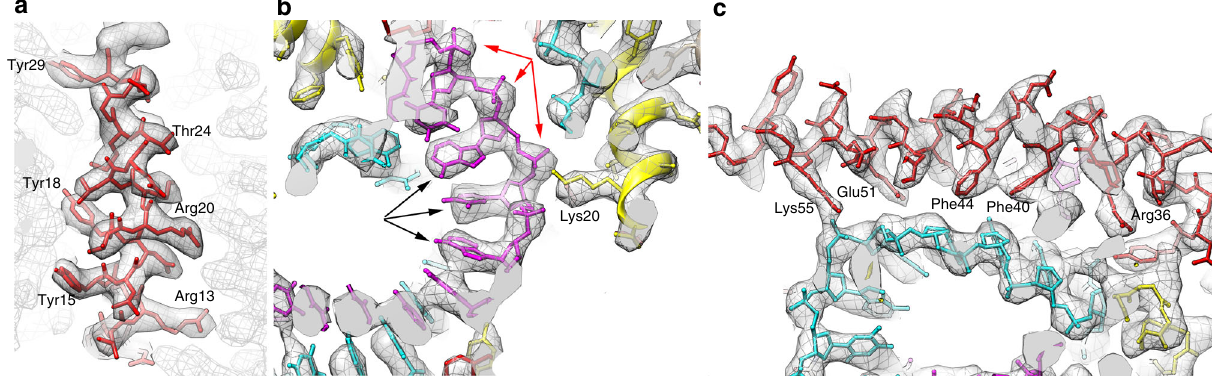
Fig. 4 The resolution of the map allows for an unambiguous modeling of both the protein and the DNA. a A helix from VP5 shows how almost all side chains can be visualized and built into the model. b A section of the DNA is shown, with one chain in magenta and the other in cyan. Even though the reconstruction is averaging over the whole genome, most of the bases are clearly resolved (black arrows) and the discrete densities from the phosphate groups are seen (red arrows). A positively-charged side chain from VP4 (Lys20) is adjacent to the negatively-charged phosphate groups. c The wrapping of the DNA (cyan) by VP5 (red). Two positively-charged sidechains (Lys55 and Arg36) are in close proximity to the phosphate backbone, while two hydrophobic residues (Phe44 and Phe40) are inserted into the groove in the DNA and are in proximity to the bases